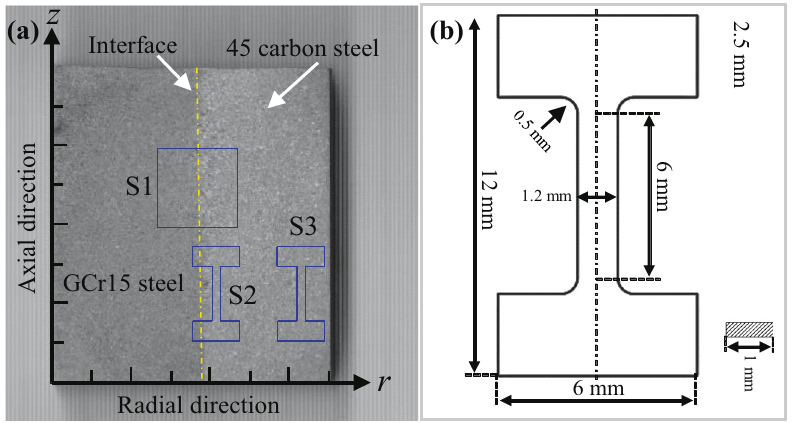
Figure 9: Sampling schematic of the tensile specimens ( a ) composite specimen and ( b ) detailed size.